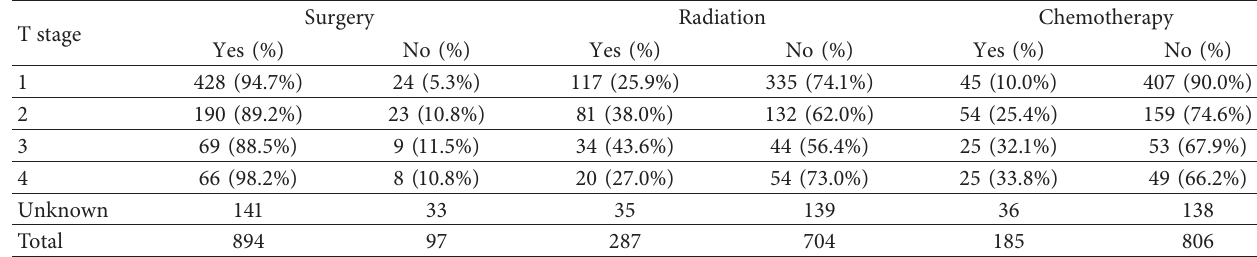
Table 5: Summary of treatment: treatment by T